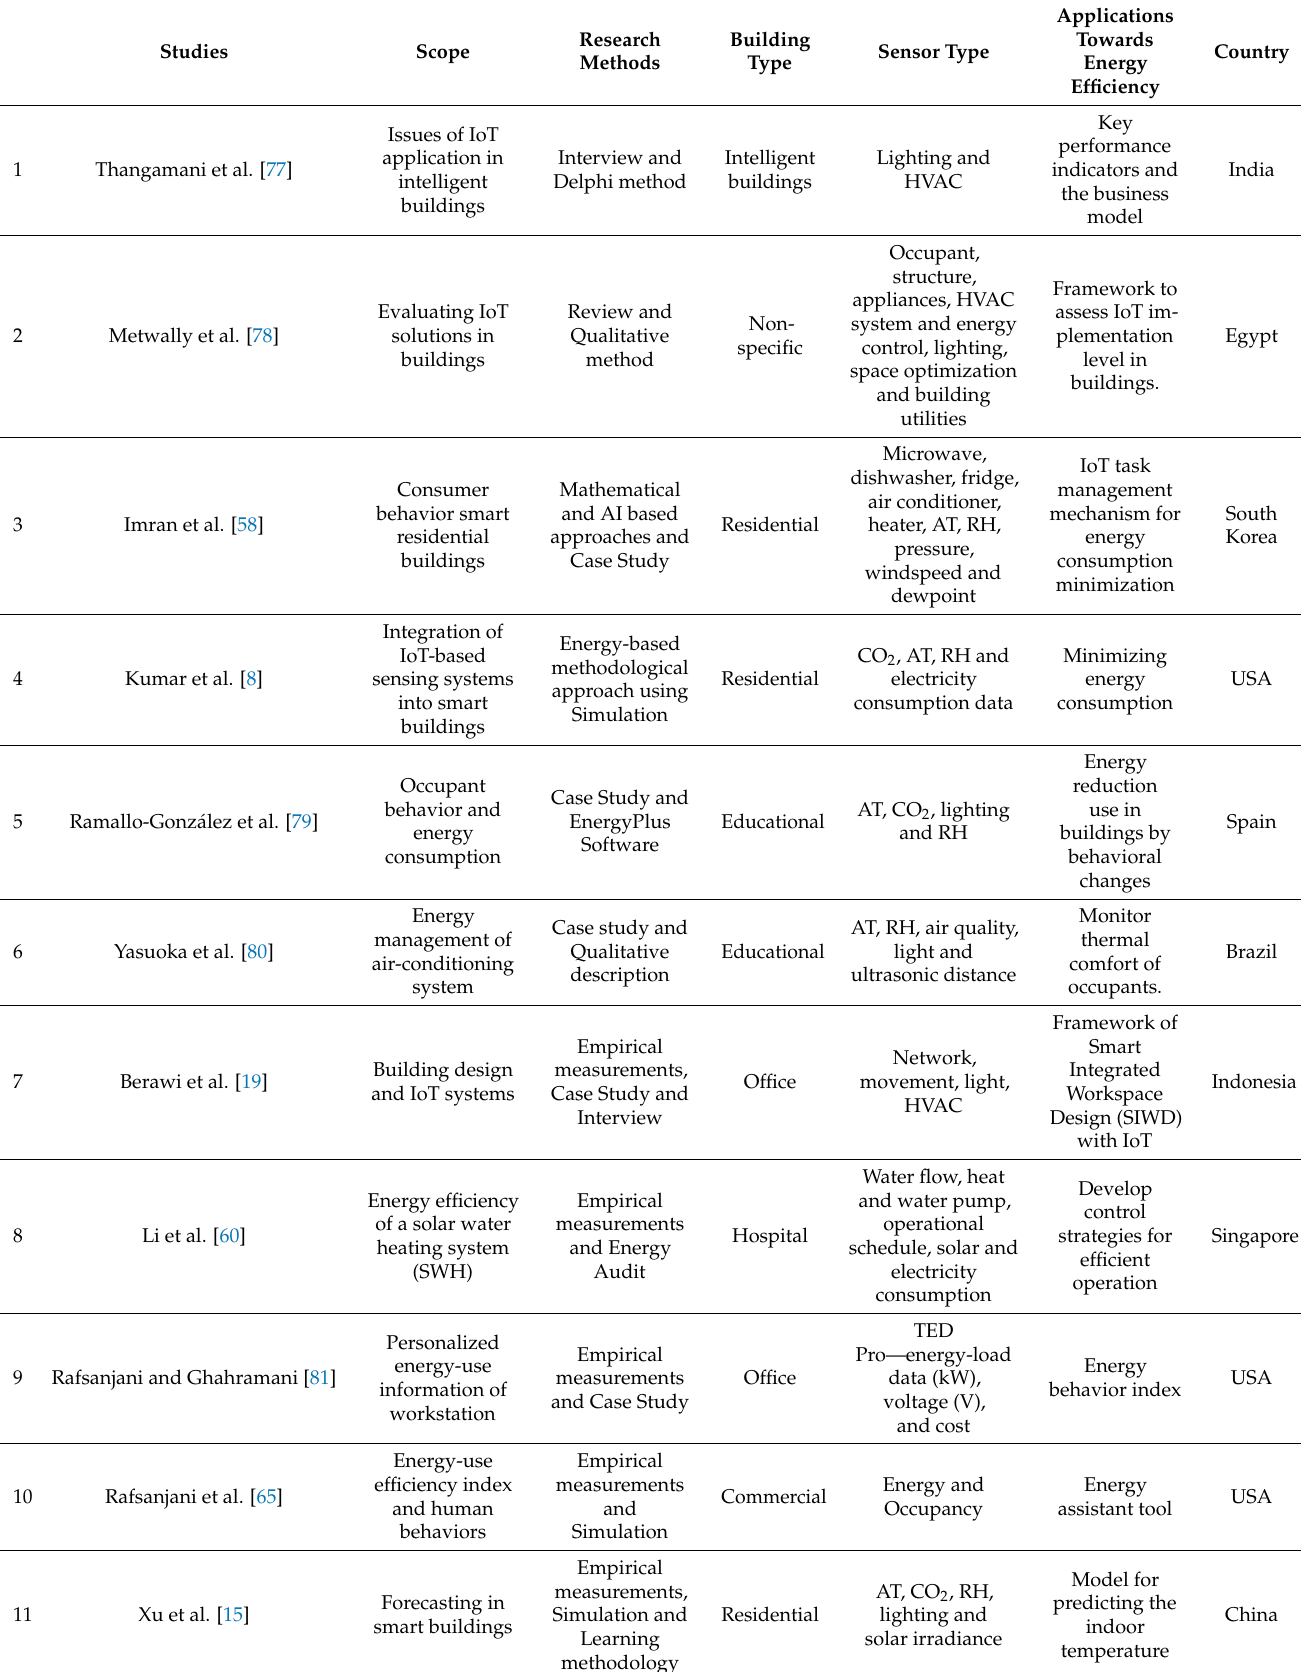
Table 2. Summary of recent studies on IoT towards energy efficiency in smart